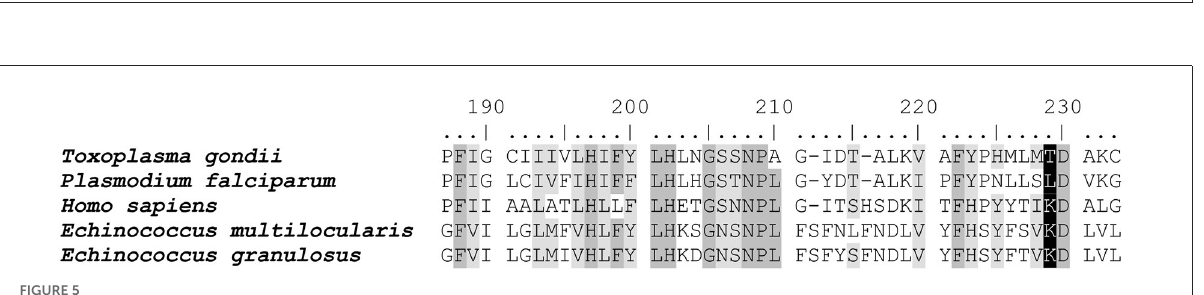
FIGURE5 Sequence comparisons of the cytochrome b of Echinococcus spp. and apicomplexan parasites. Sequence alignment of the Qi site of cytochrome b between E. multilocularis (C6L2E3), T. gondii (S8EQL3) and P. falciparum (Q02768), and H. sapiens (P00156; EgrG_900000100). The T. gondii position 222 is highlighted in black. Conserved sites are marked in gray (four out of five amino acids same) and in light gray (three out of five amino acids same). Position 222 is labeled in black. The entire sequence alignment is given in Supplementary Figure